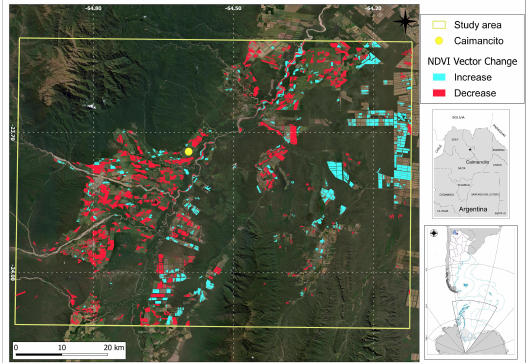
Figure 4. Change vector obtained from the difference NDVI between 2015 and 2018. Red colour shows the decrease in NDVI, and light blue colour shows the increase. Background